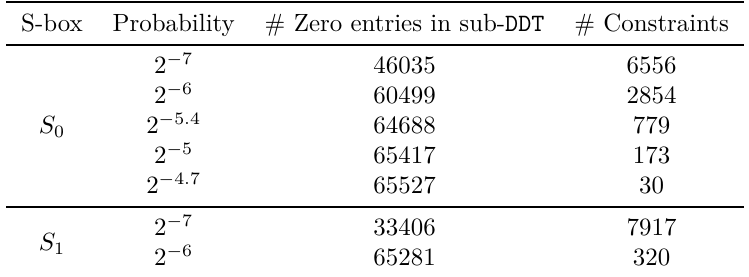
Table 5: Number of MILP constraints to encode the pb - DDT s of CLEFIA .